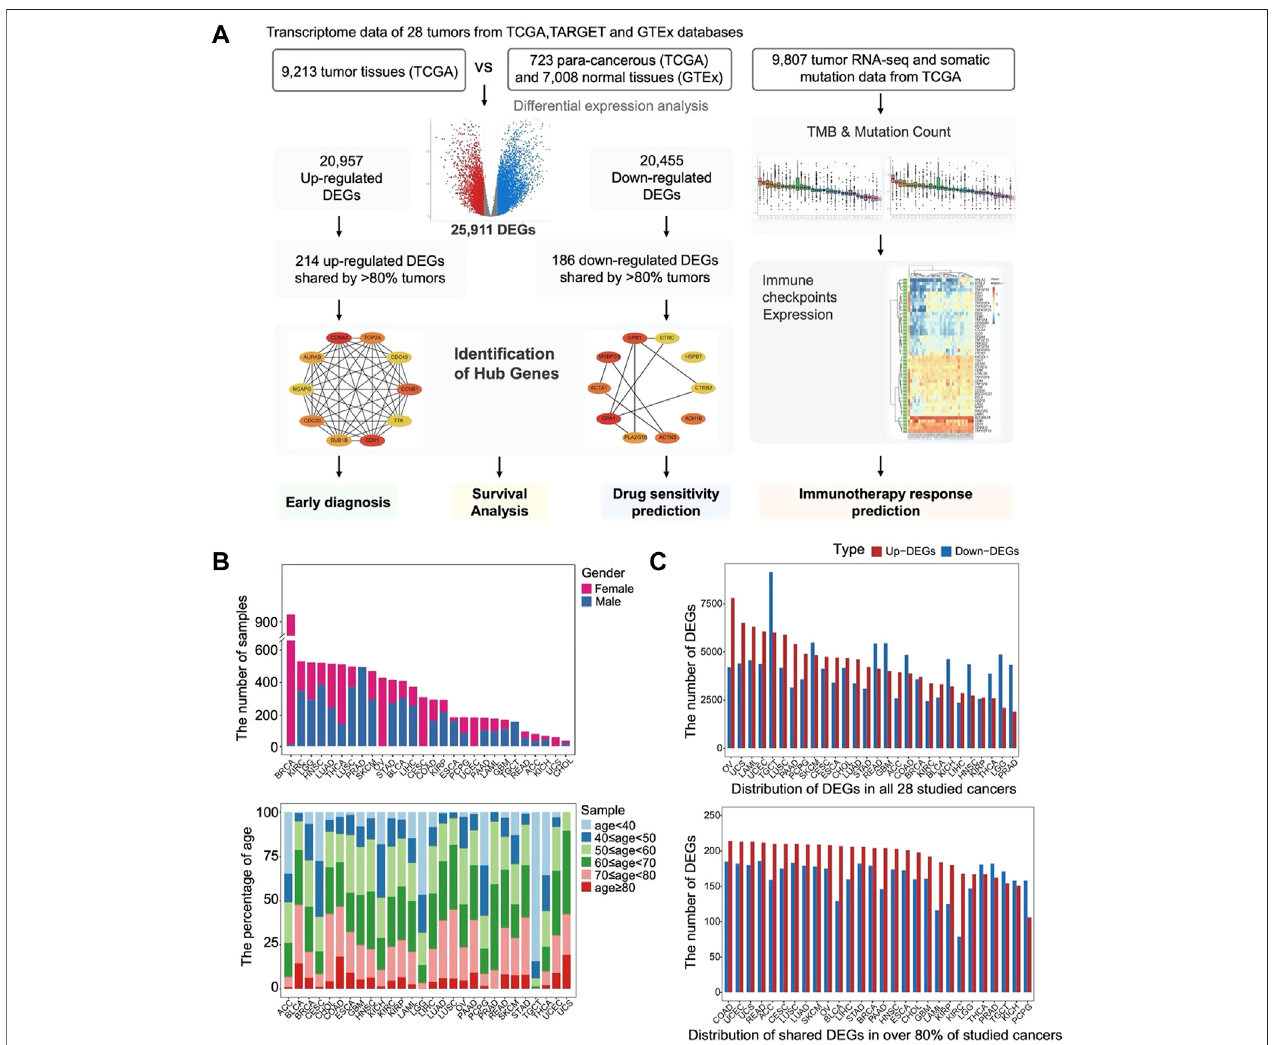
FIGURE1| Thelandscapeofdistribution ofDEGsamongalltumors. (A) Work fl owdepictingacollection ofTCGA,GTExdatasets,andprocessingofbioinformatic analysisforRNA-seqofpan-cancer. (B) Ageandgenderdistributionofthe28tumorsamples. (C) DistributionofDEGsinall28studiedcancersanddistributionofshared DEGs in over 80% of studied